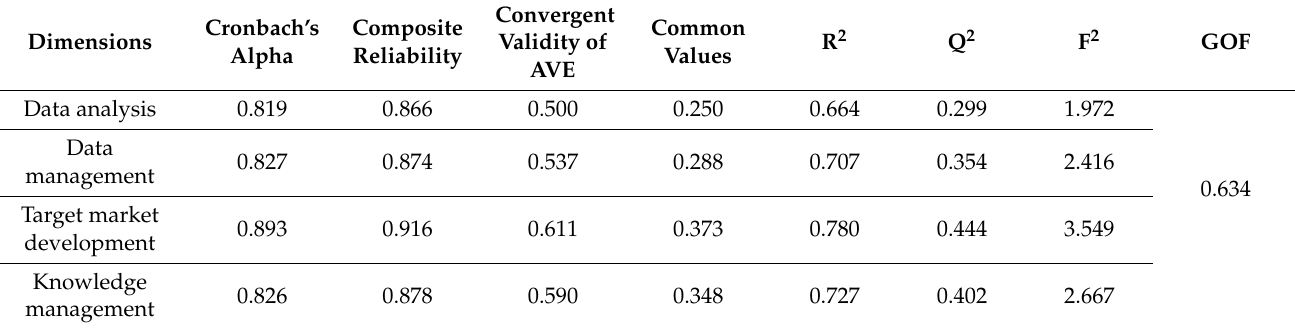
Table 1. Fit values of business intelligence questionnaire.